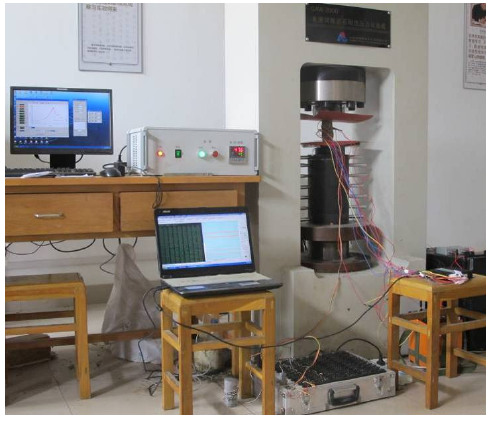
Figure 2. The test system.